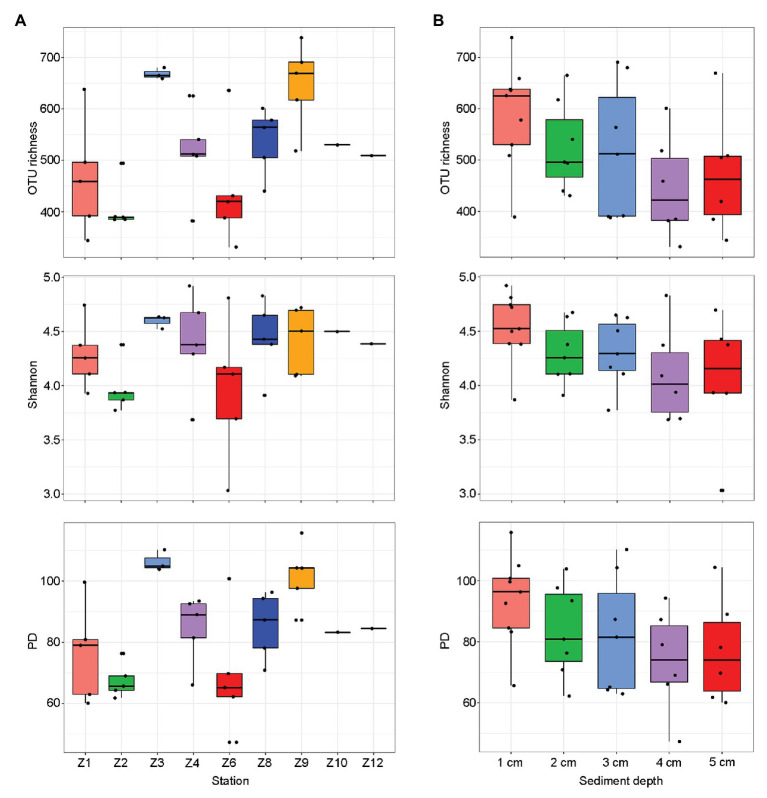
Alpha-diversity estimates [operational taxonomic unit (OTU) richness, Shannon, and phylogenetic diversity (PD)] for each sampling sites (A) and sediment depths (B), respectively. The line in each box plot indicates the median, the box delimits the 25th and 75th percentile.